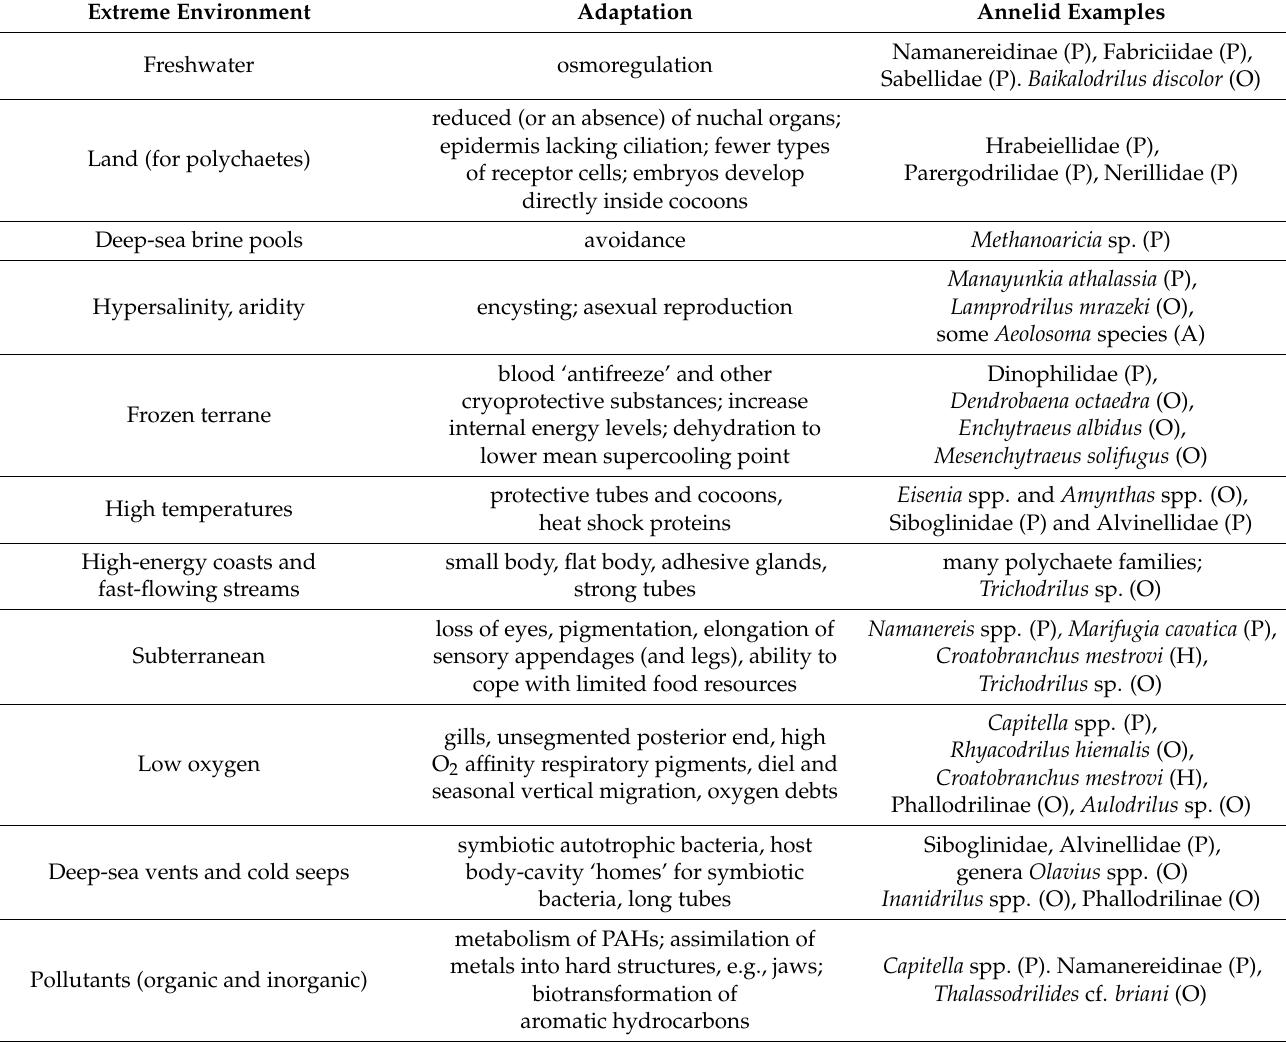
Table 1. Extremophile annelids and their adaptations. P = polychaete, O = oligochaete, H = hirudinid, and A = aphanoneuran. Extreme